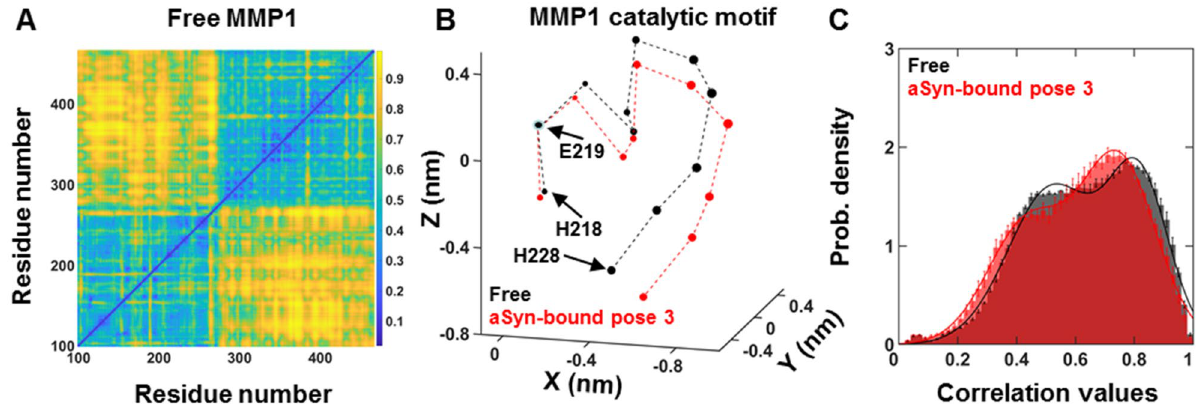
Figure 6. Conformational changes near the catalytic motif and identification of allosteric residues in MMP1 at 37 °C. ( A ) Normalized correlations between each pair of residues for free active MMP1 at 37 °C. ( B ) Three- dimensional configurations of the catalytic motif residues for free active MMP1 (black) and aSyn-bound MMP1 (red) at 37 °C. ( C ) Histograms of correlation values of free MMP1 (black) and aSyn-bound MMP1 (red). For best-fit parameters, see Table